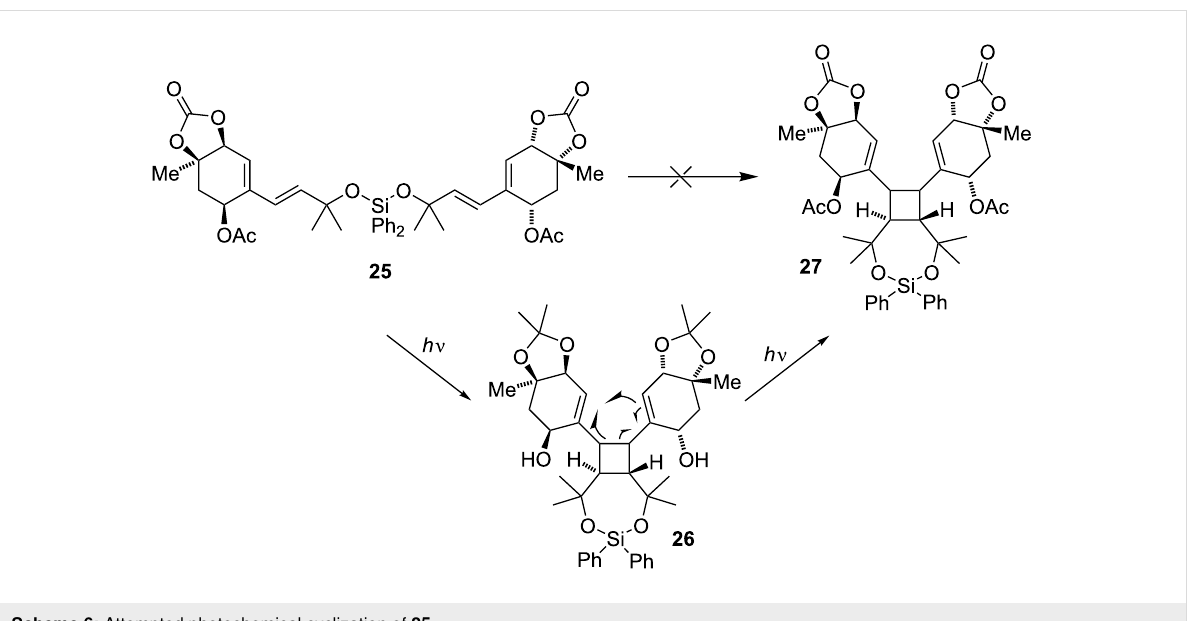
Scheme 6: Attempted photochemical cyclization of 25